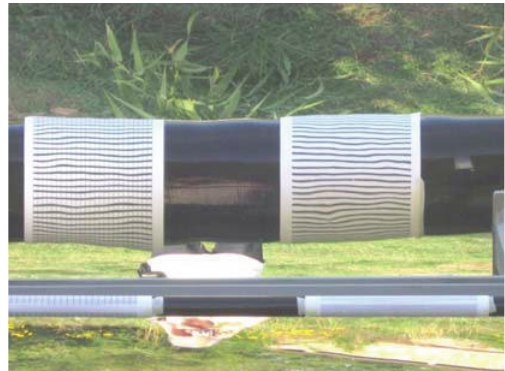
Figure 1: Image of the reference grating reflected on the concentra- tor.